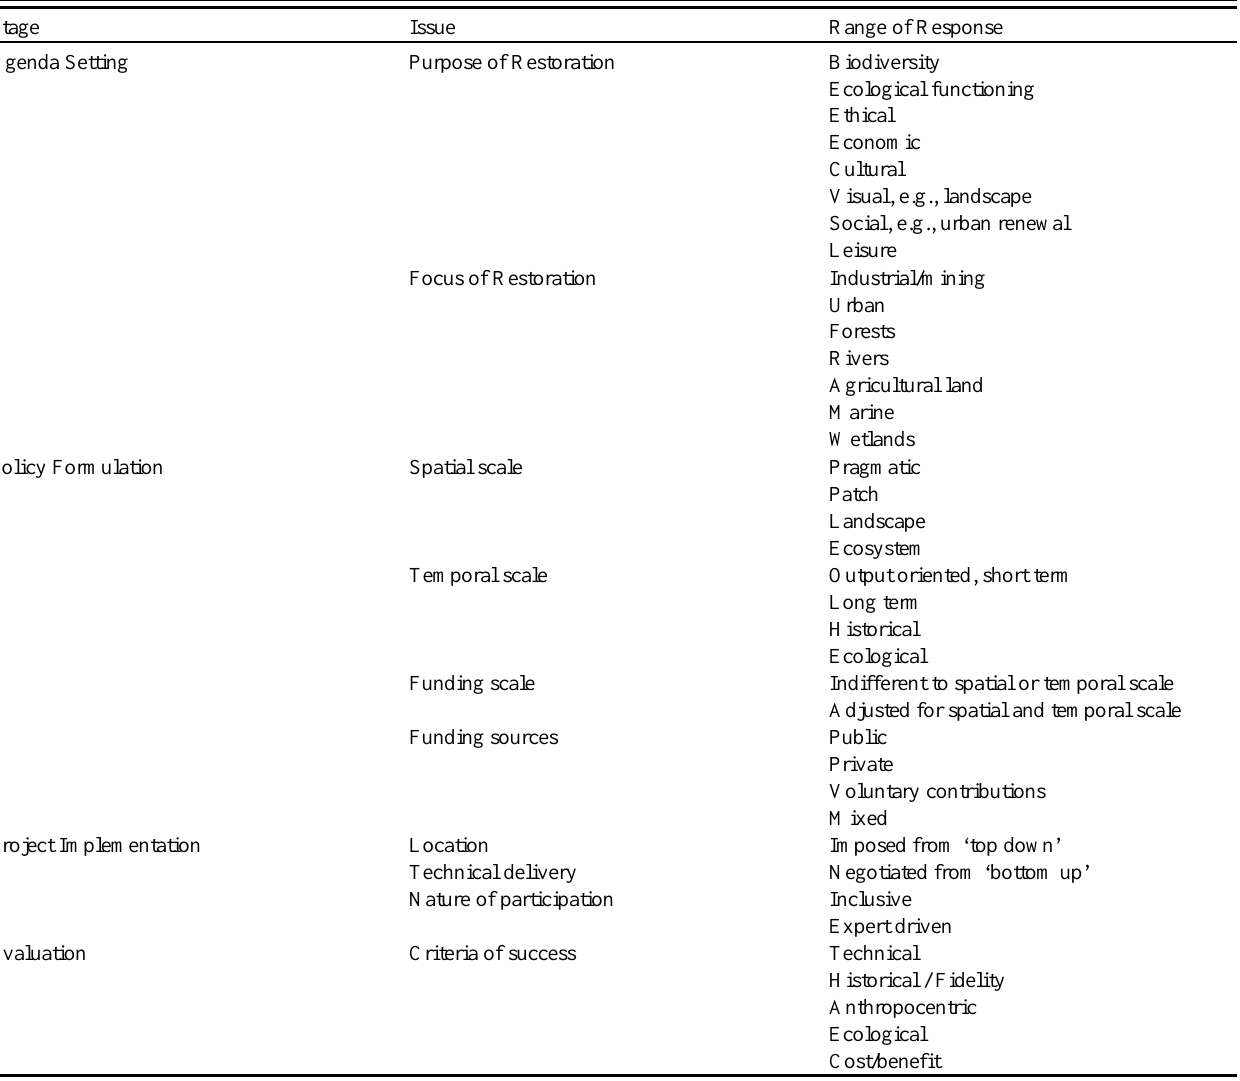
Table 1 . Negotiating nature through the policy making